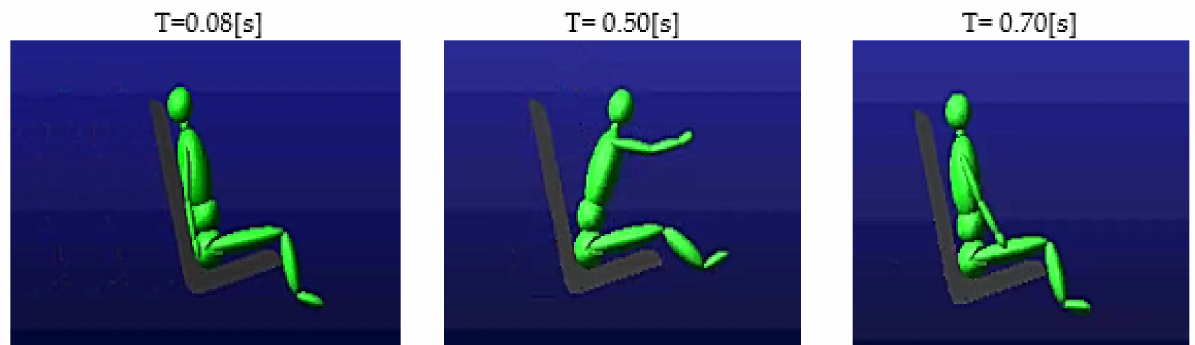
Figure 5. Displacement of the dummy at selected moments of